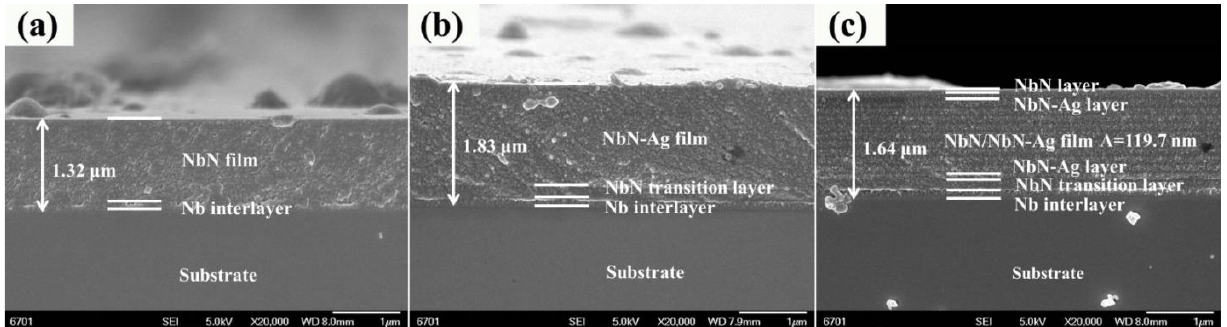
Figure 2. The FESEM cross-sectional images of the studied NbN-based nanocomposite films: ( a ) NbN; ( b ) NbN-Ag; ( c ) NbN/NbN-Ag.